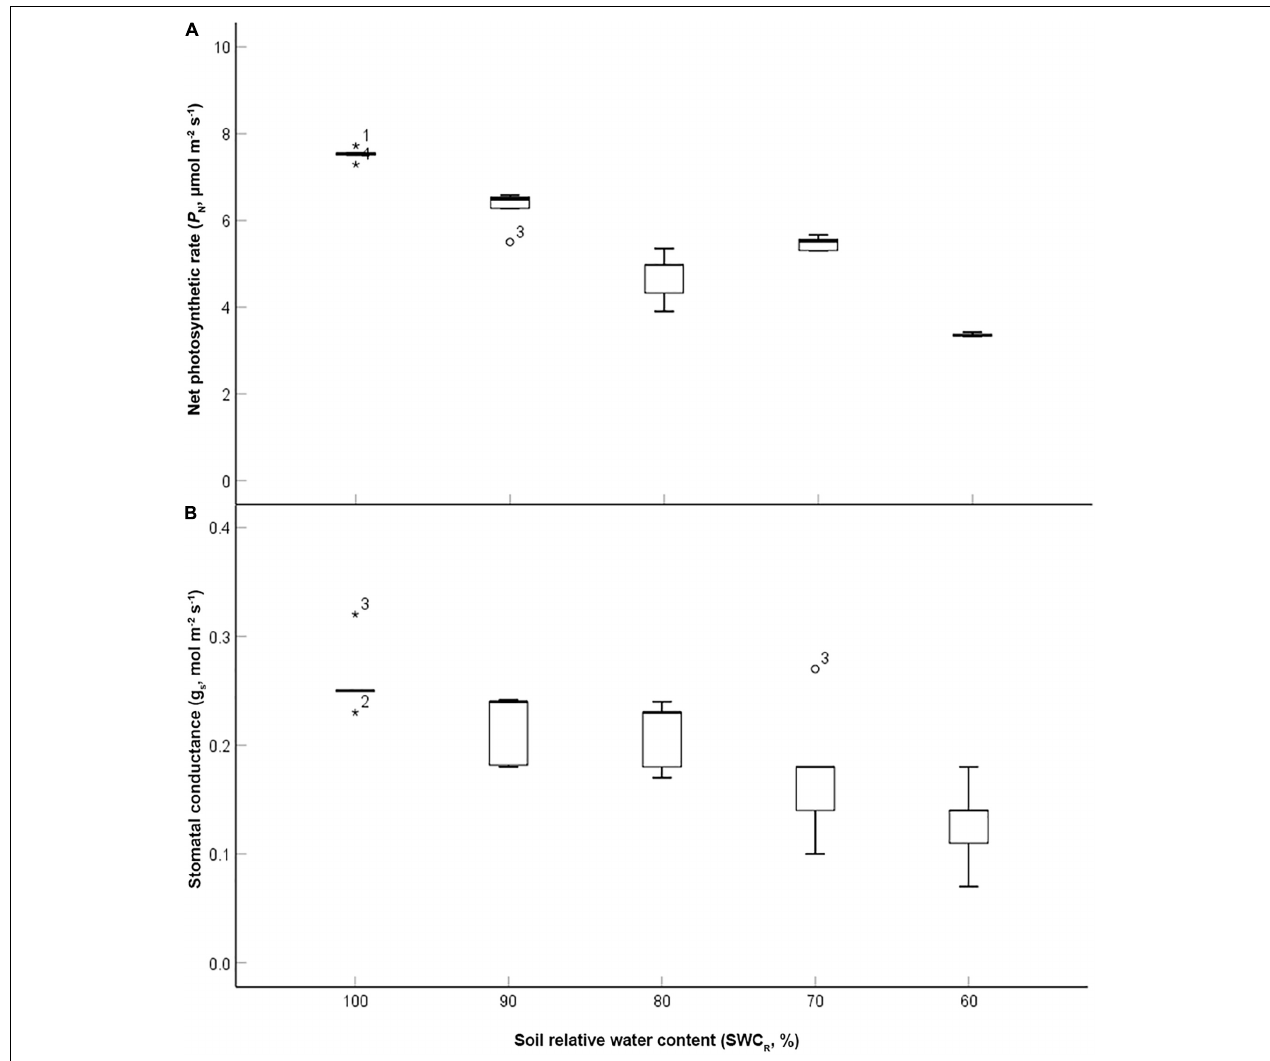
FIGURE 2 | Effect of different water supplies on net photosynthetic rate ( P N , µ mol m – 2 s – 1 ) and stomatal conductance (g s , mol m – 2 s – 1 ) [ (A) P N ; (B) g s . The asterisks and circles represent the extreme outliers].